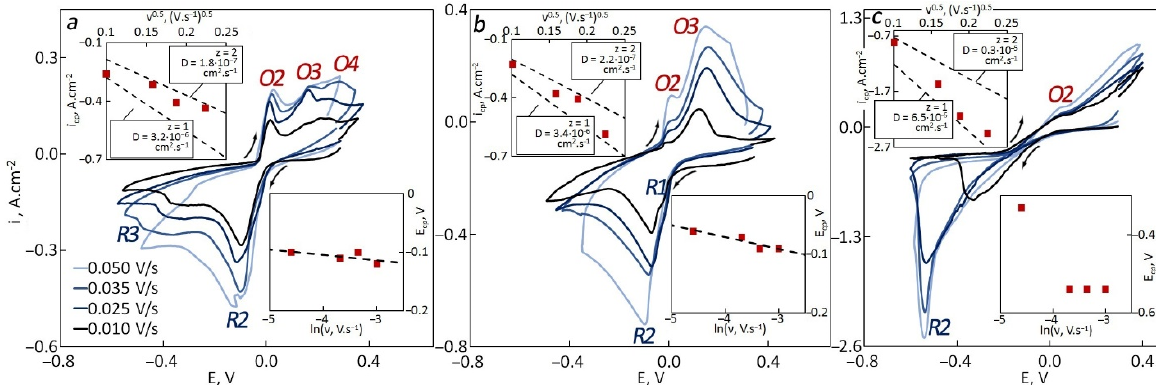
Figure 3. CVs recorded for tungsten in 85LiF–15AlF 3 (with 5 wt.% of spent catalyst) with the dependencies of cathodic peak current density vs. square root of sweep rate (upper left) and cathodic peak potential vs. logarithm of sweep rate (bottom right) for different temperatures: ( a ) 760 °C, ( b ) 780 °C, ( c ) 800 °C.